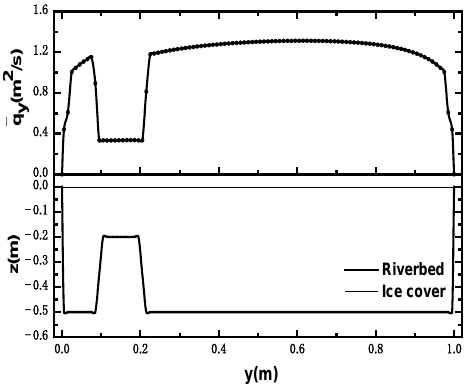
Figure 10. Experimental flume section with main channel and floodplain: ( a ) section topography showing ice cover, riverbed distribution, and cross-sectional relative-unit discharge; ( b ) photo of experimental flume.